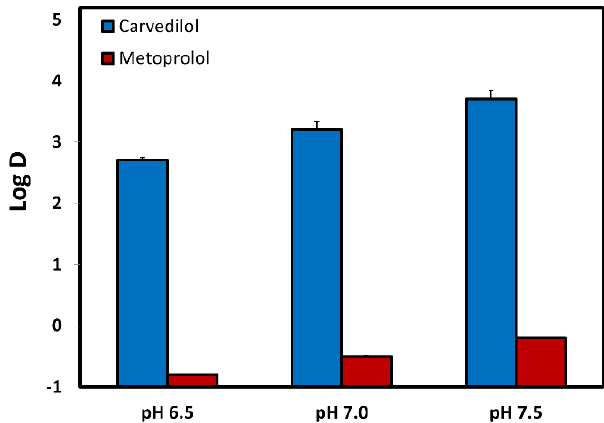
Figure 2. The octanol-buffer distribution coefficients for carvedilol vs. metoprolol at pH values of 6.5, 7.0, and 7.5. Values are presented as means ± SD; n = 6.